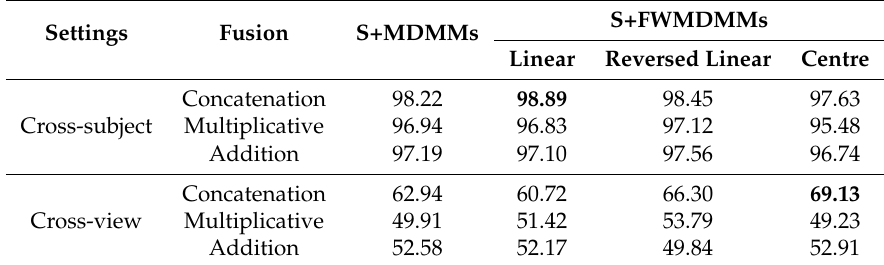
Table 4. Performance of the proposed method in terms of NUCLA dataset using FWMDMMs fused with spatial information (depth and